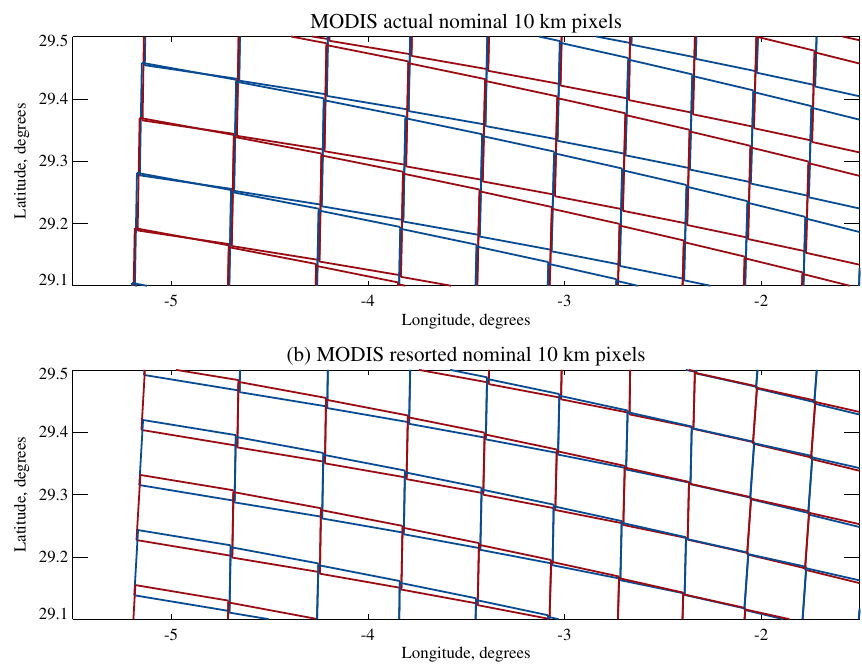
Figure 7. Actual L2 retrieval-pixel boundaries for (a) the standard (Figs. 4c and 5) and (b) resorted aggregation techniques.